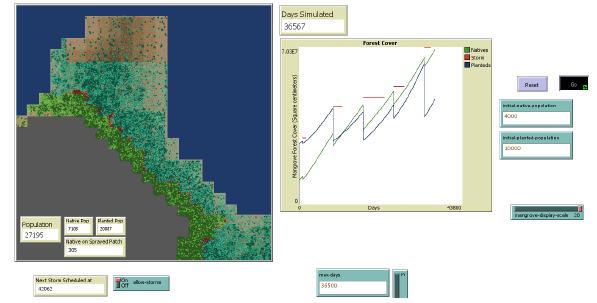
Figure 1: A simulation with a success rate of 30% On average, sprayed patches assist the growth of native man- groves only when they are near a native mangrove. Although